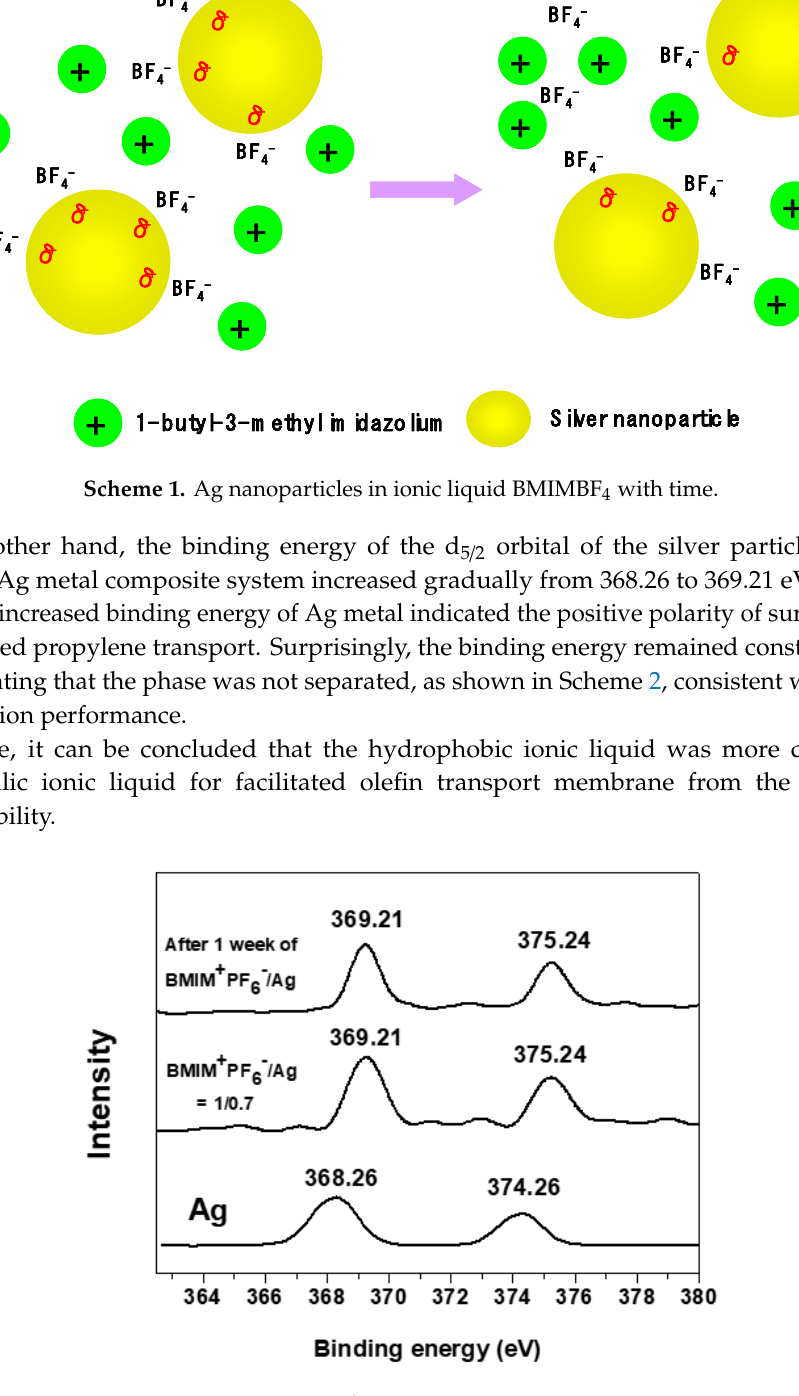
Figure 4. Binding energy of Ag in 1/0.7 BMIM + BF 4 − /Ag composites after preparation and after 1 week.